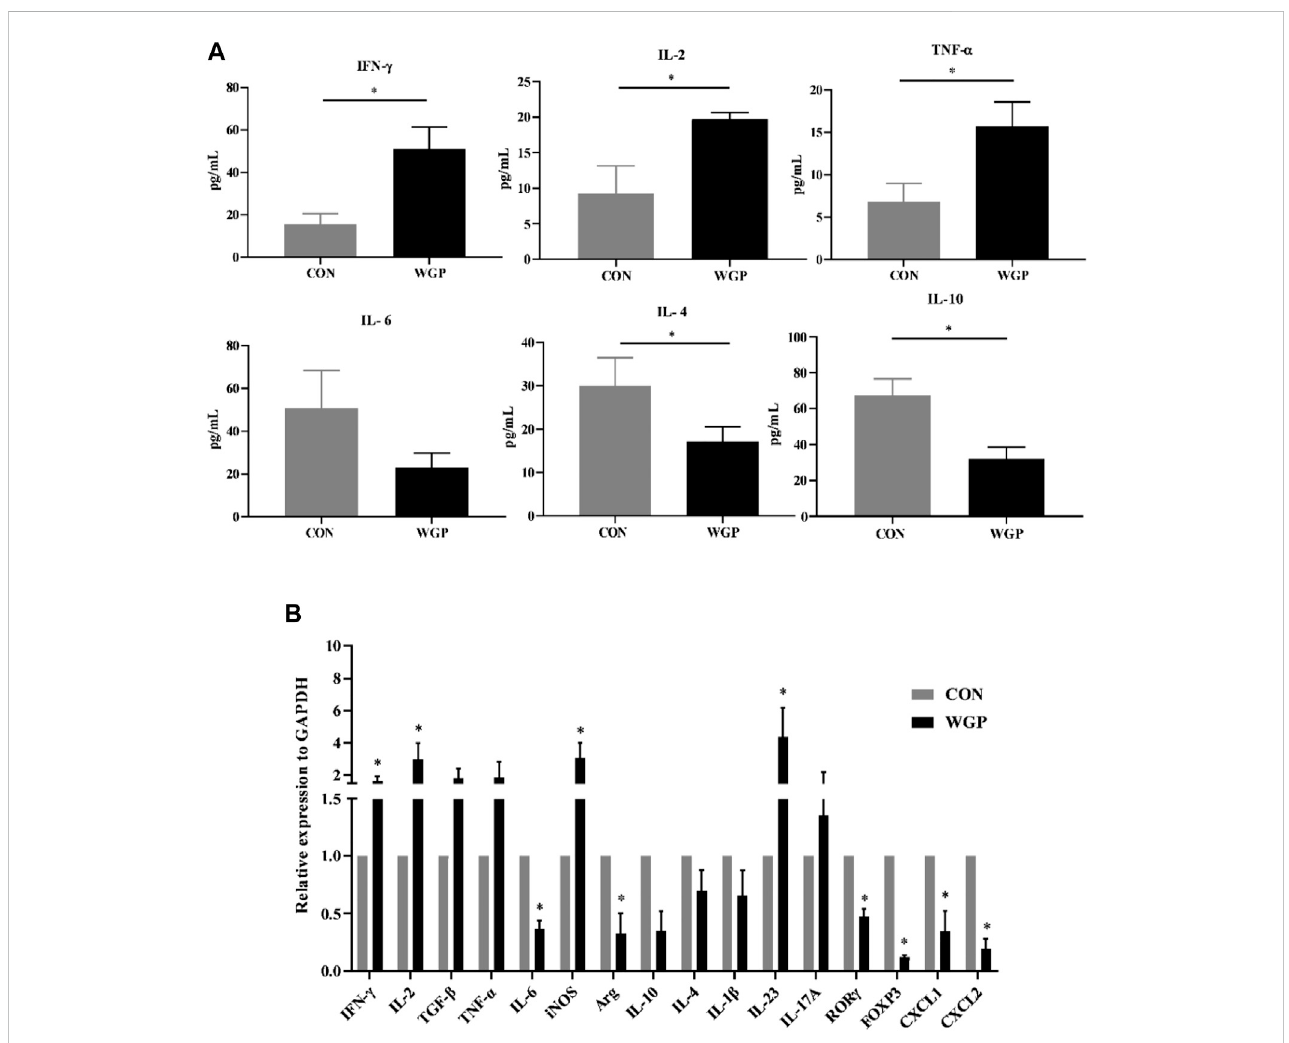
FIGURE 3 WGP alters the production of in fl ammatory cytokines and chemokines (A) After WGP treatment, multiple in fl ammatory cytokines were detected in the serum of AOM/DSS-treated mice by fl ow cytometry. (B) The mRNA expression of immune response-related molecules in the TME was determined by quantitative reverse transcription-PCR andcalculated bythe2 − ΔΔ Ct method ( n =5 – 6). Representative results from threeindependentexperiments are shown. Data represent the mean ± SEM. Statistical signi fi cance was determined by two-sided unpaired Student ’ s t-test. *p <